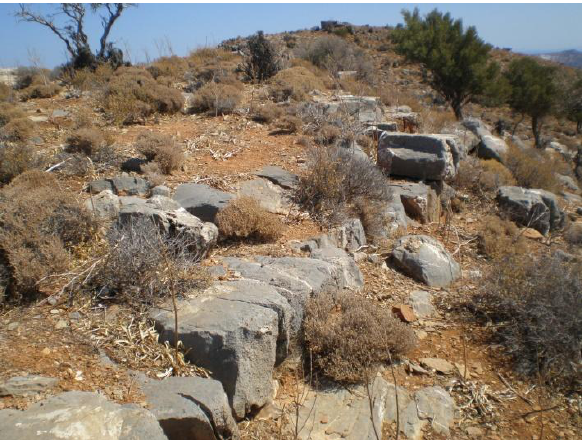
Figure 2. Agios Antonios Chomatas Site 9: the actual state of the